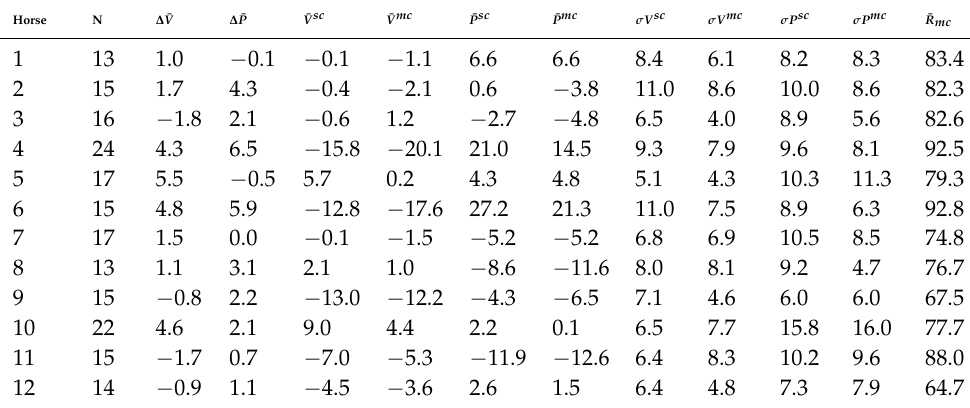
Table 2. Descriptive statistics for pelvic measurements from the 23 included horses showing the number of matched strides per trial (N) and the mean trial deviations between the two systems for the valley values ∆ ¯ V (MinDiff) and peak values ∆ ¯ P (MaxDiff). Also, the actual trial means for the ¯ V (MinDiff) and the ¯ P are presented per trial for the multi camera marker based ( mc ) and the single camera markerless system ( sc ), followed by their within trial standard deviation ( σ V and σ P ). From the mc , the trial mean range of motion of the vertical displacement signal is